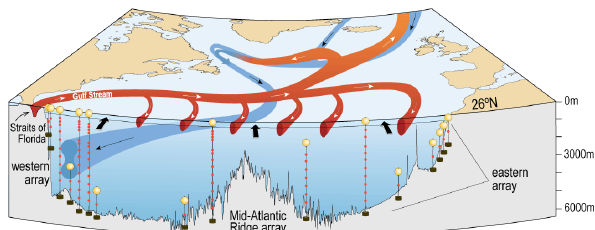
Fig. 1. Schematic diagram illustrating the component parts of the AMOC and the 26 ◦ N observing system. Black arrows represent the Ekman transport (predominantly northward). Red arrows illustrate the circulation of warm waters in the upper 1100m, and blue arrows indicate the main southward flow of colder deep waters. The array of moorings used to measure the interior geostrophic transport is illustrated